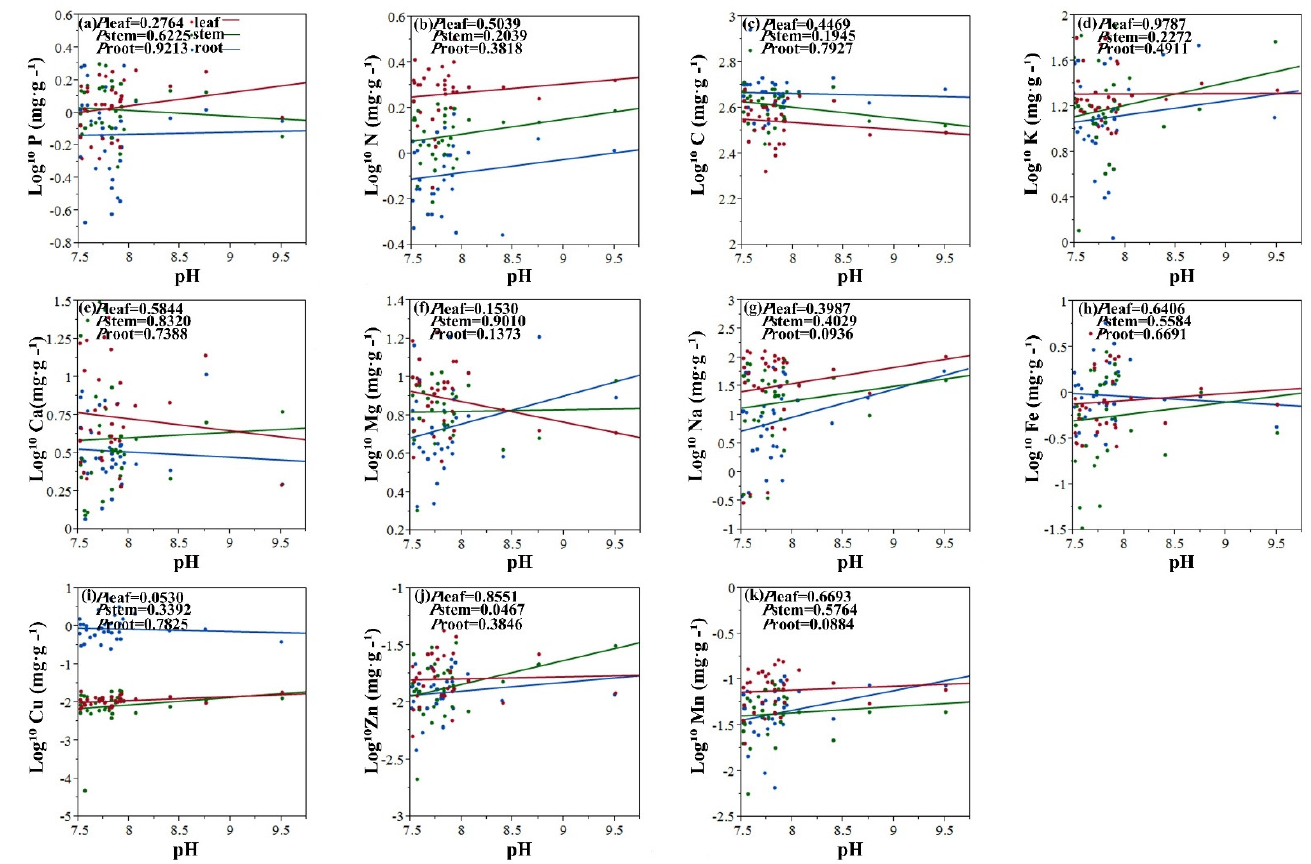
Figure 2. Linear relationships of pH with concentration of 11 elements among leaves, stems and roots. Colored lines represent significant relationships ( p < 0.05) for halophytes (red, leaves; blue, stems; green, roots). (a)Linear relationship between Log 10 P (mg g − 1 ) and pH. (b)Linear relationship between Log 10 N (mg g − 1 ) and pH. (c)Linear relationship between Log 10 C (mg g − 1 ) and pH. (d)Linear relationship between Log 10 K (mg g − 1 ) and pH. (e)Linear relationship between Log 10 Ca (mg g − 1 ) and pH. (f)Linear relationship between Log 10 Mg (mg g − 1 ) and pH. (g)Linear relationship between Log 10 Na (mg g − 1 ) and pH. (h)Linear relationship between Log 10 Fe (mg g − 1 ) and pH. (i)Linear relationship between Log 10 Cu (mg g − 1 ) and pH. (j)Linear relationship between Log 10 Zn (mg g − 1 ) and pH. (k)Linear relationship between Log 10 Mn (mg g − 1 ) and pH.